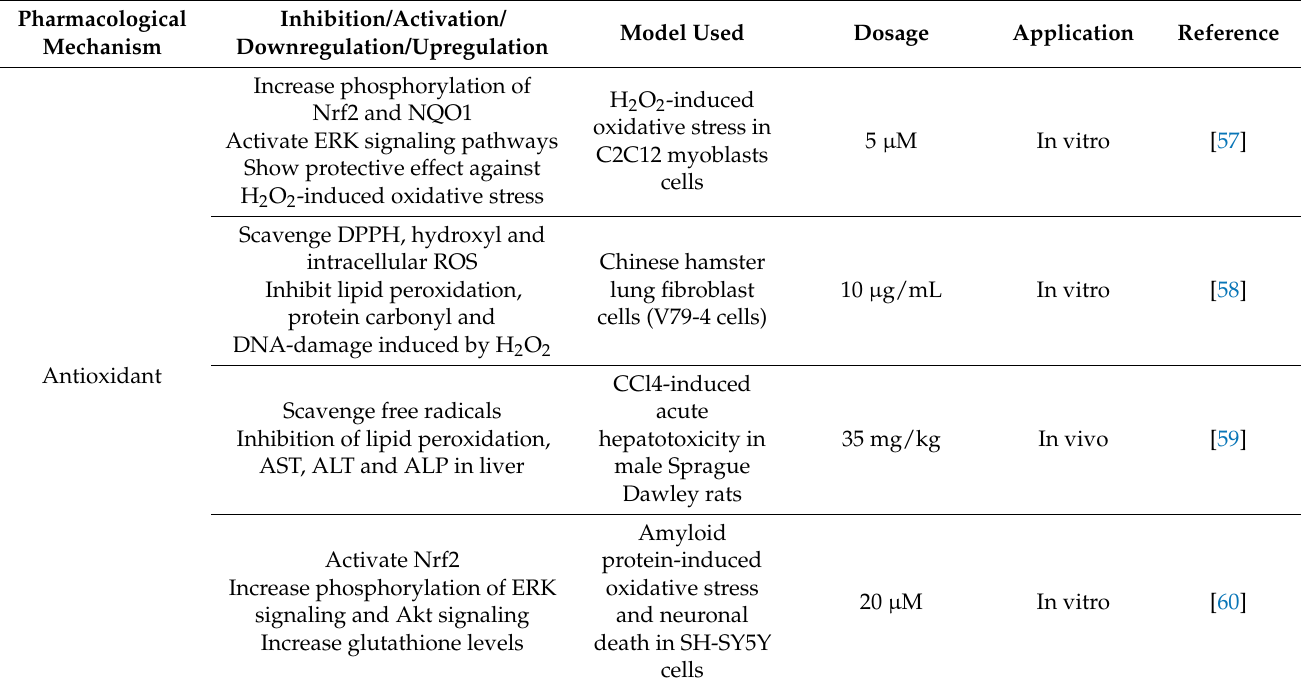
Table 2. Mechanism and function of esculetin in treatment of oxidative